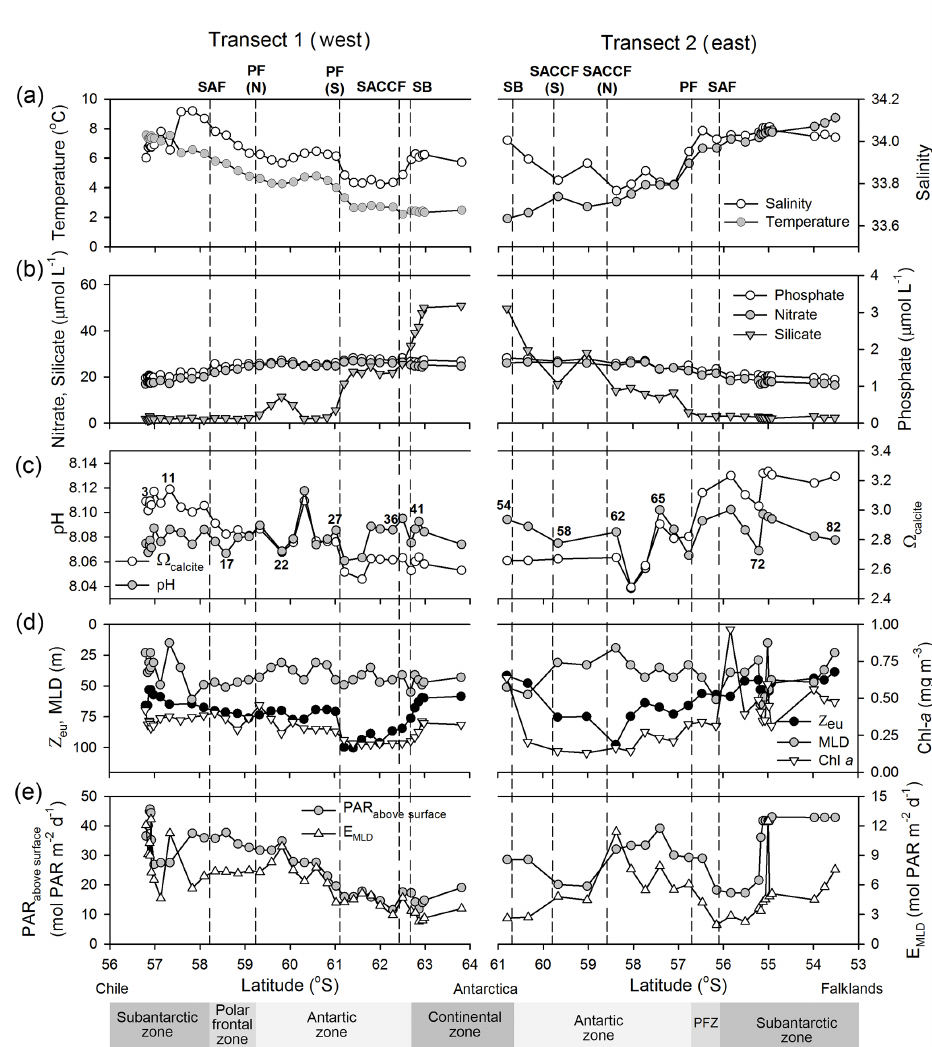
Figure 2. Surface distribution of physicochemical environmental variables along Transect 1 (left) and Transect 2 (right). (a) Temperature and salinity. (b) Nitrate, silicate and phosphate concentrations. (c) pH T and calcite saturation state ( (cid:127) C ) . (d) Euphotic zone depth ( Z eu ) , mixed layer depth (MLD) and Chl a . (e) Above-surface irradiance (PAR above surface ) and mixed layer irradiance ( E MLD )